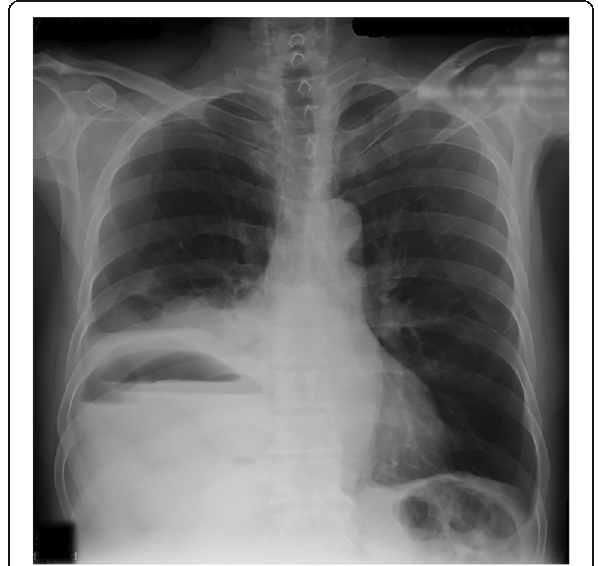
Fig. 2 Chest X-ray: air accumulation above the